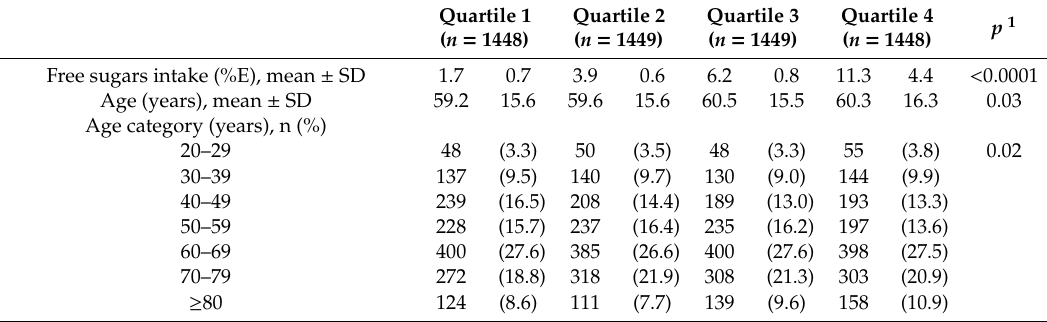
Table 3. Basic characteristics of Japanese women ( n = 5794) according to free sugars intake: the 2016 National Health and Nutrition Survey,